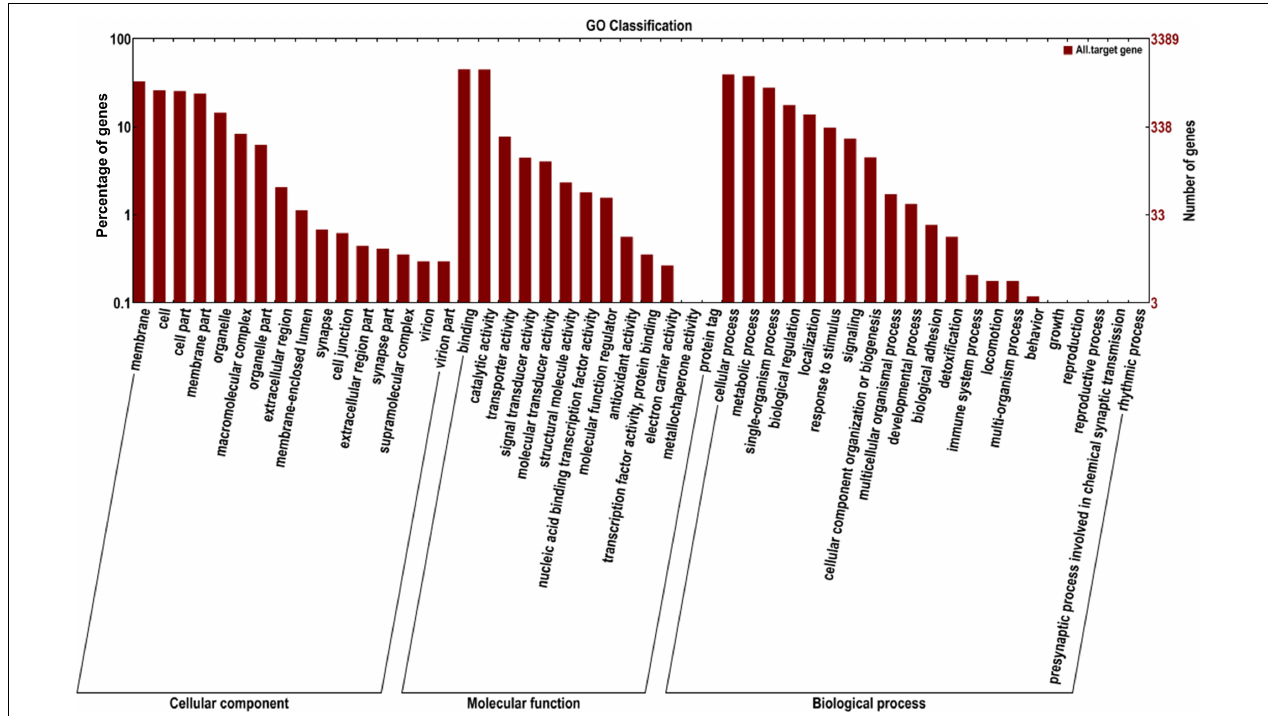
FIGURE 5 | Gene ontology (GO) annotation of the genes targeted by identified miRNAs. The X-axis shows the GO annotation, and the Y-axis shows the ordinate left in the percentage of